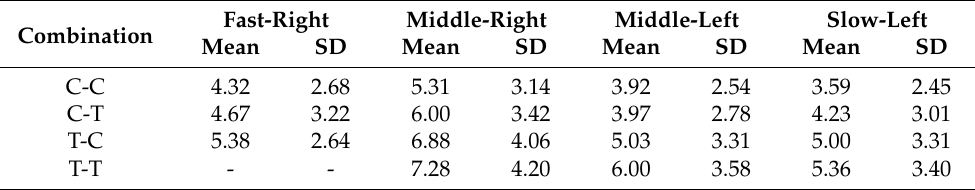
Table A12. The mean and standard deviation of THW of m and n2.